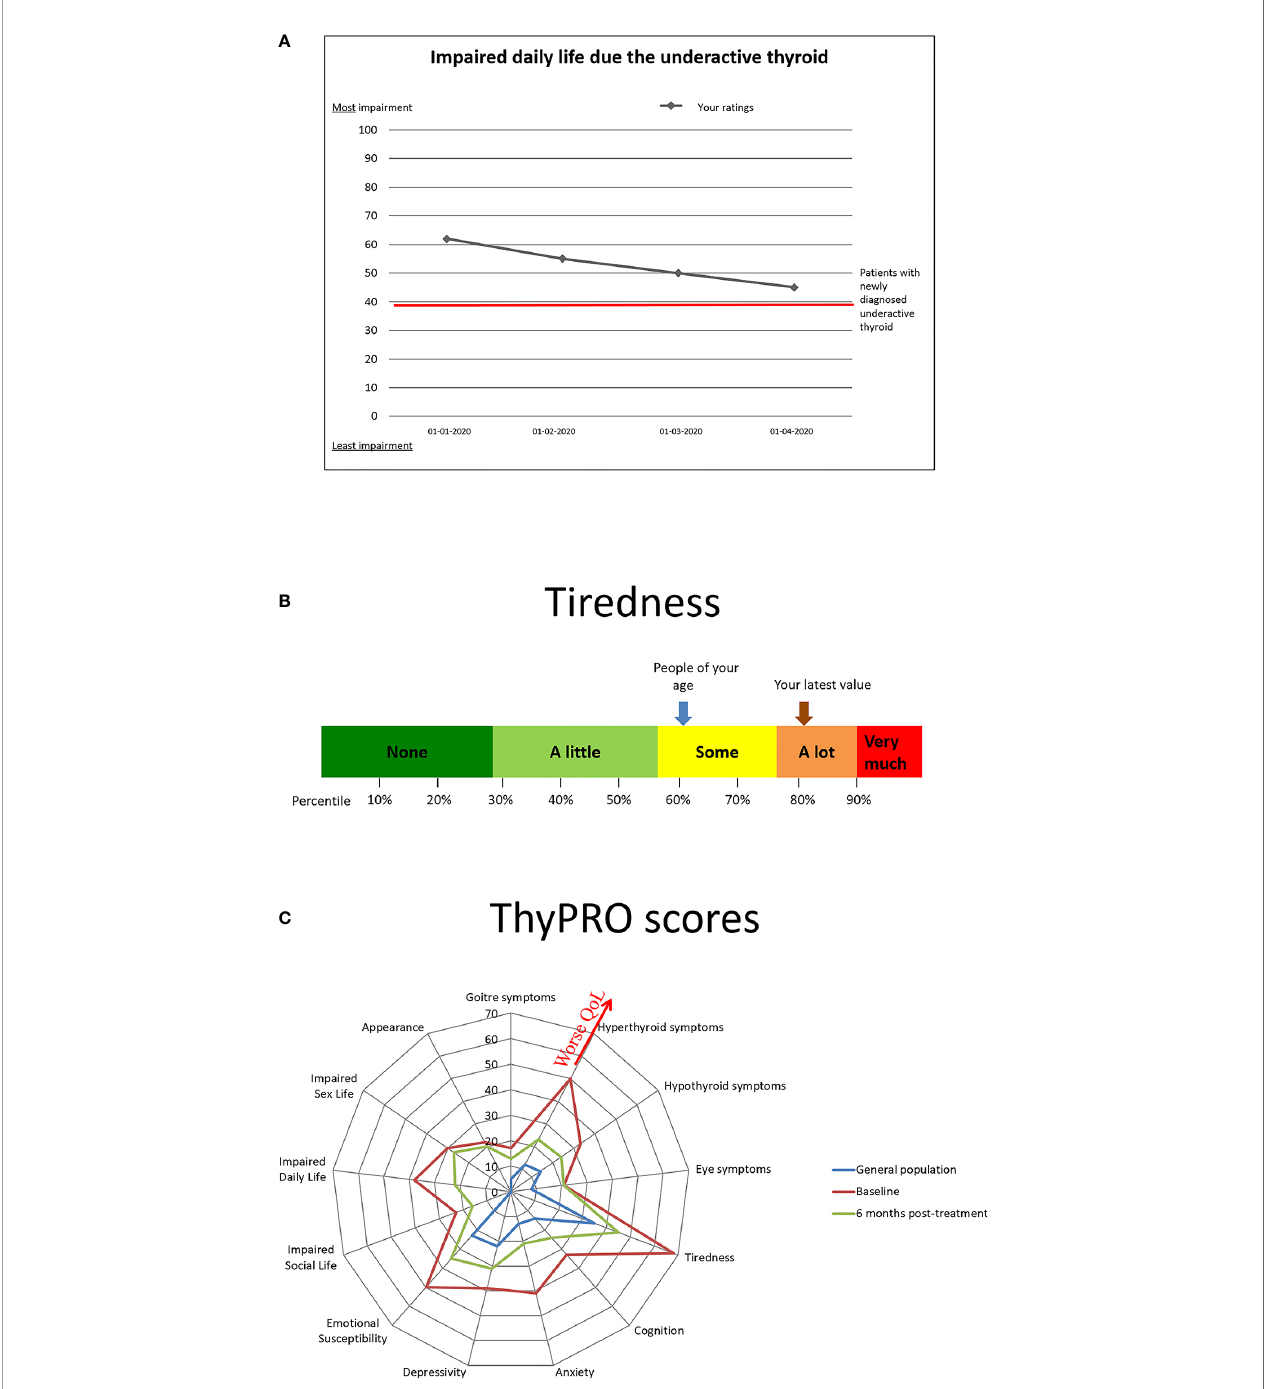
FIGURE 2 | Examples of presentations of results from patient-reported outcomes recorded prior to a patient visit. (A) Patient-oriented presentation with reference to previous ratings. (B) Patient-oriented presentation with reference values as percentiles and general population reference. (C) Clinician-oriented multidimensional quality of life (QoL)